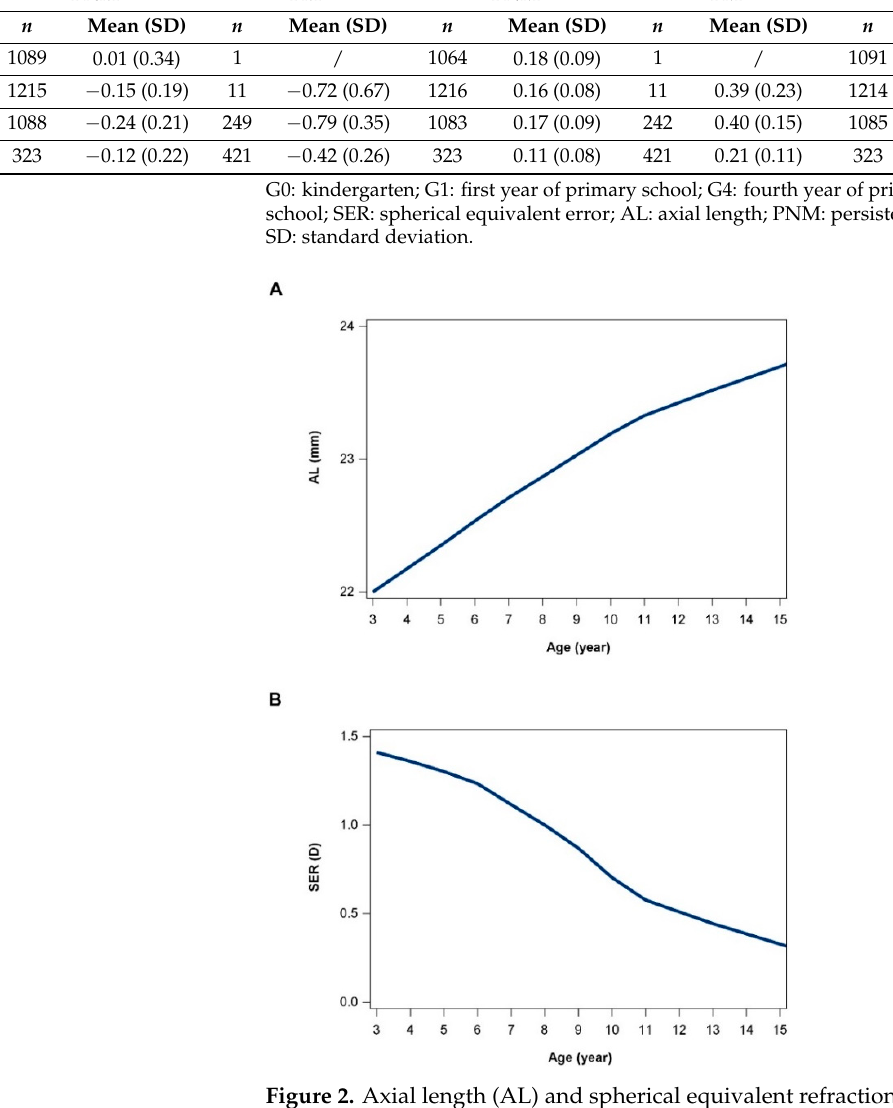
Table 2. SER, AL and body height change during two-year follow-up.